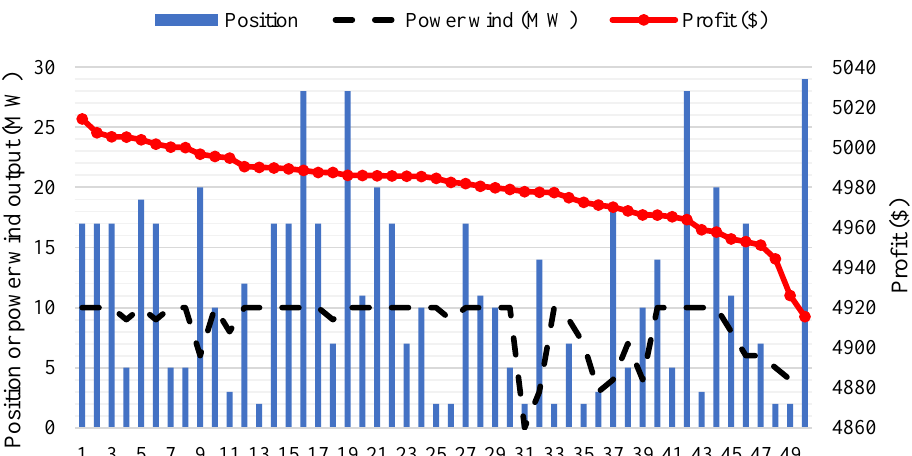
Figure 14. Optimal location and size of wind turbine obtained by MSA for 50 runs.